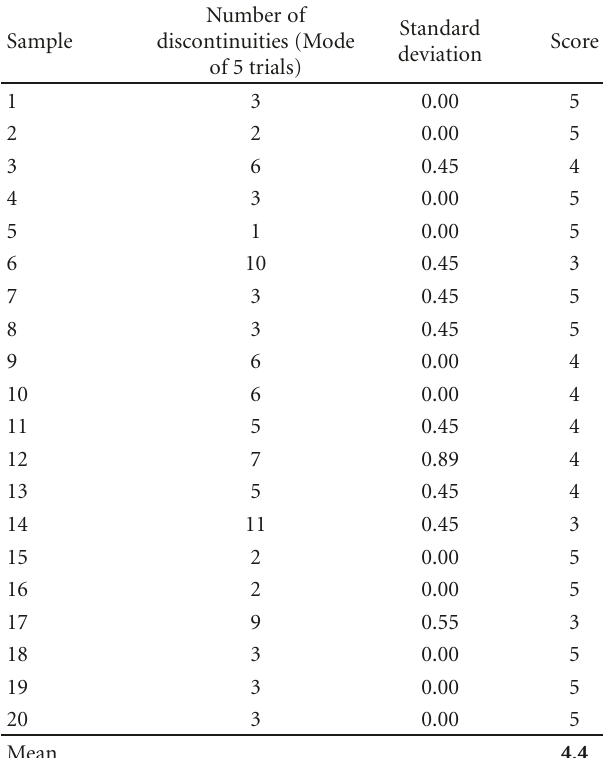
Table 4: Tree growth model quality scores for the twenty populus samples. Here, the variable frequency spacing filterbank was used (see Table 2 for the